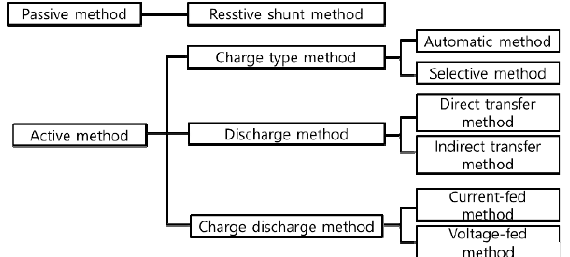
Figure 1. Battery balancing types.